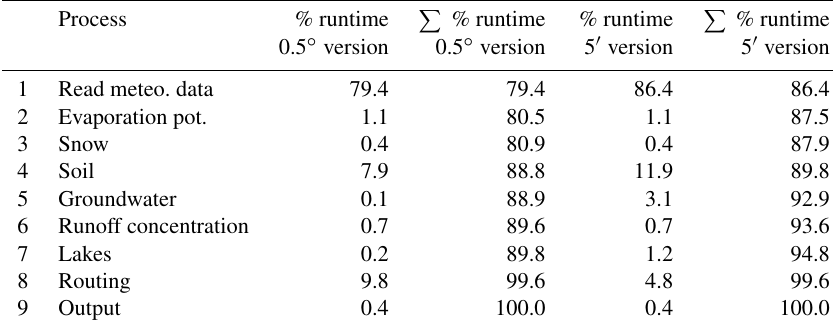
Table 4. Computational time for 0.5 ◦ and 5 (cid:48) runs – Rhine basin (same as Table 3).